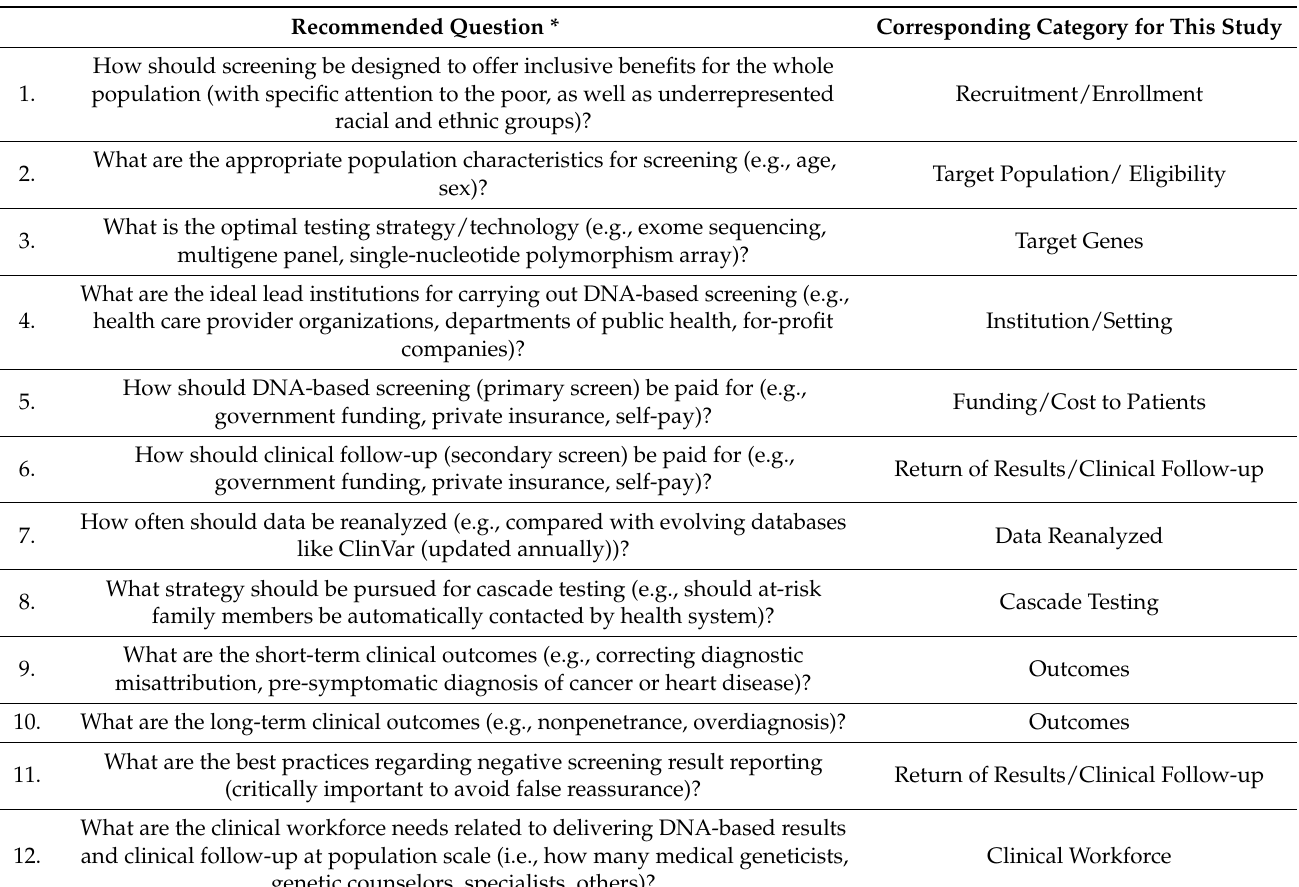
Table 1. Recommended 12 questions to be addressed in pilot studies of general population screening used for this